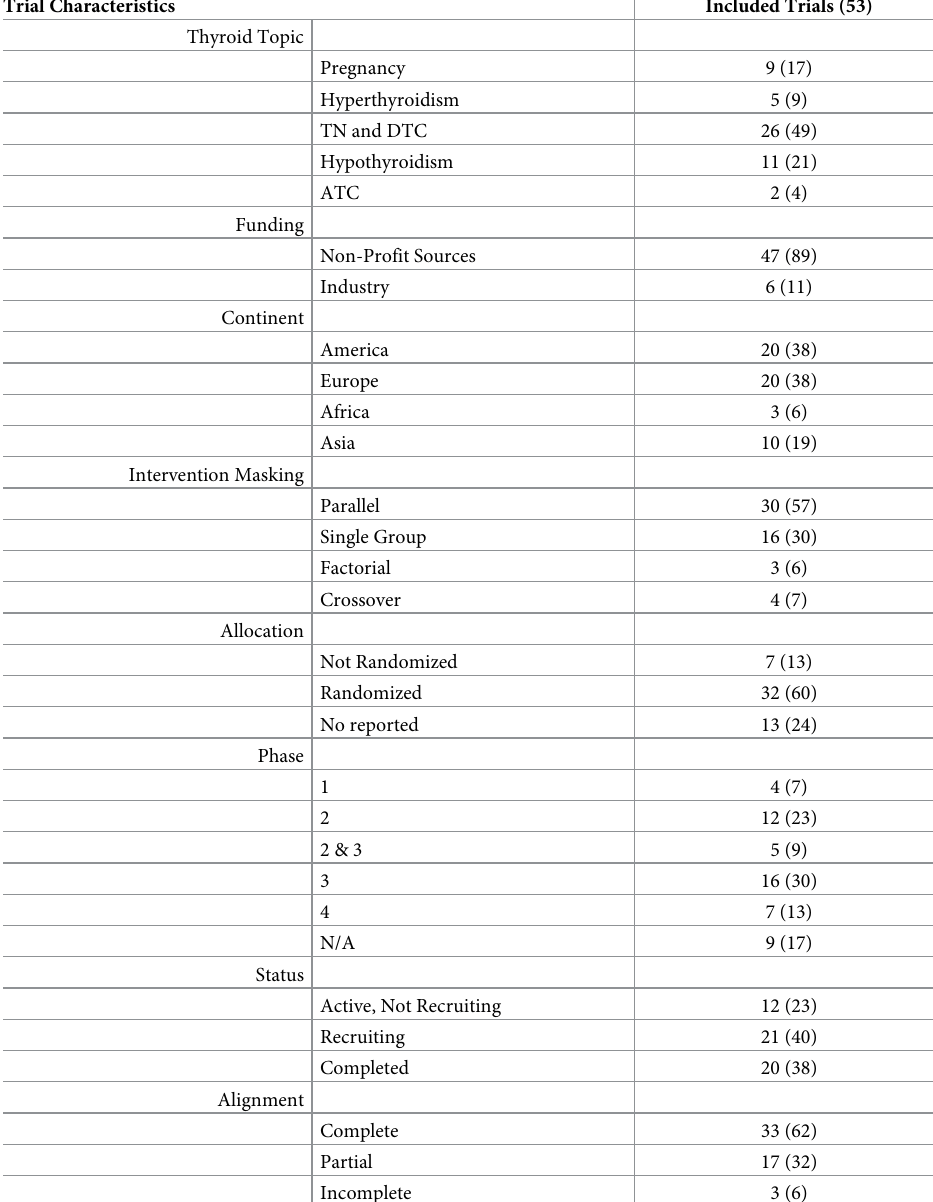
Table 1. Description of interventional